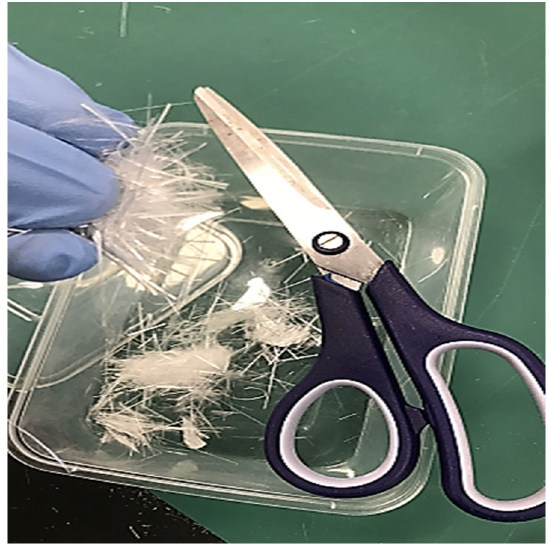
Figure 2. Sorting and cutting of glass fibres.